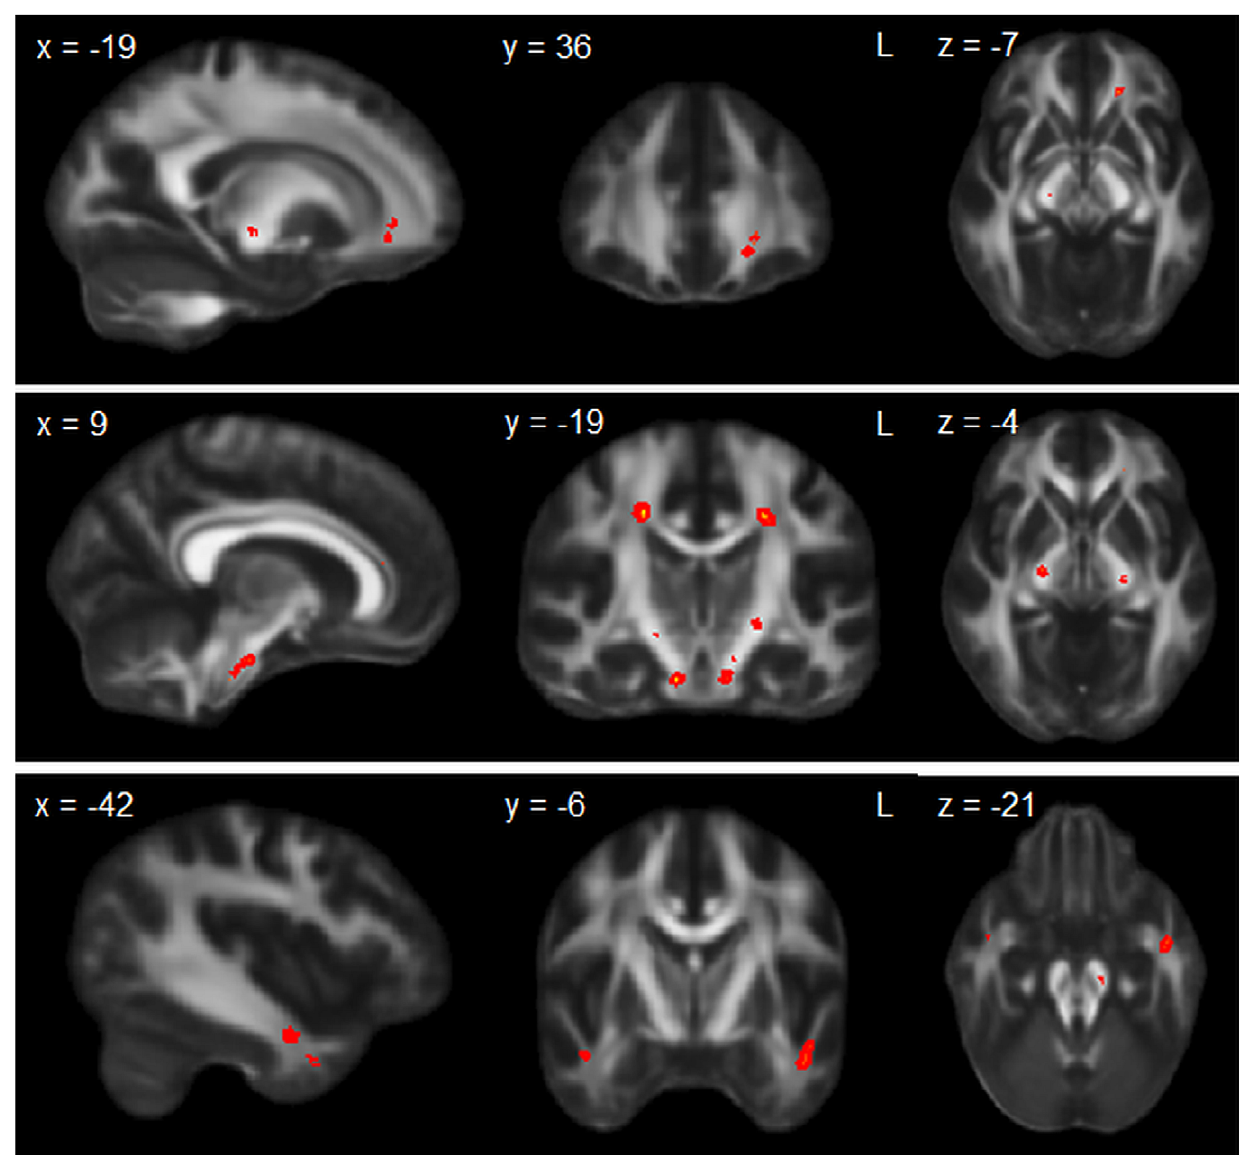
Figure 4. Overlap white matter changes across patient groups. Diffusion tensor imaging analysis showing regions of unique white matter changes across groups. Clusters are overlaid on the MNI standard brain (t=2.41). Coloured voxels show regions that were significant in the analyses for p , 0.05 FWE corrected.